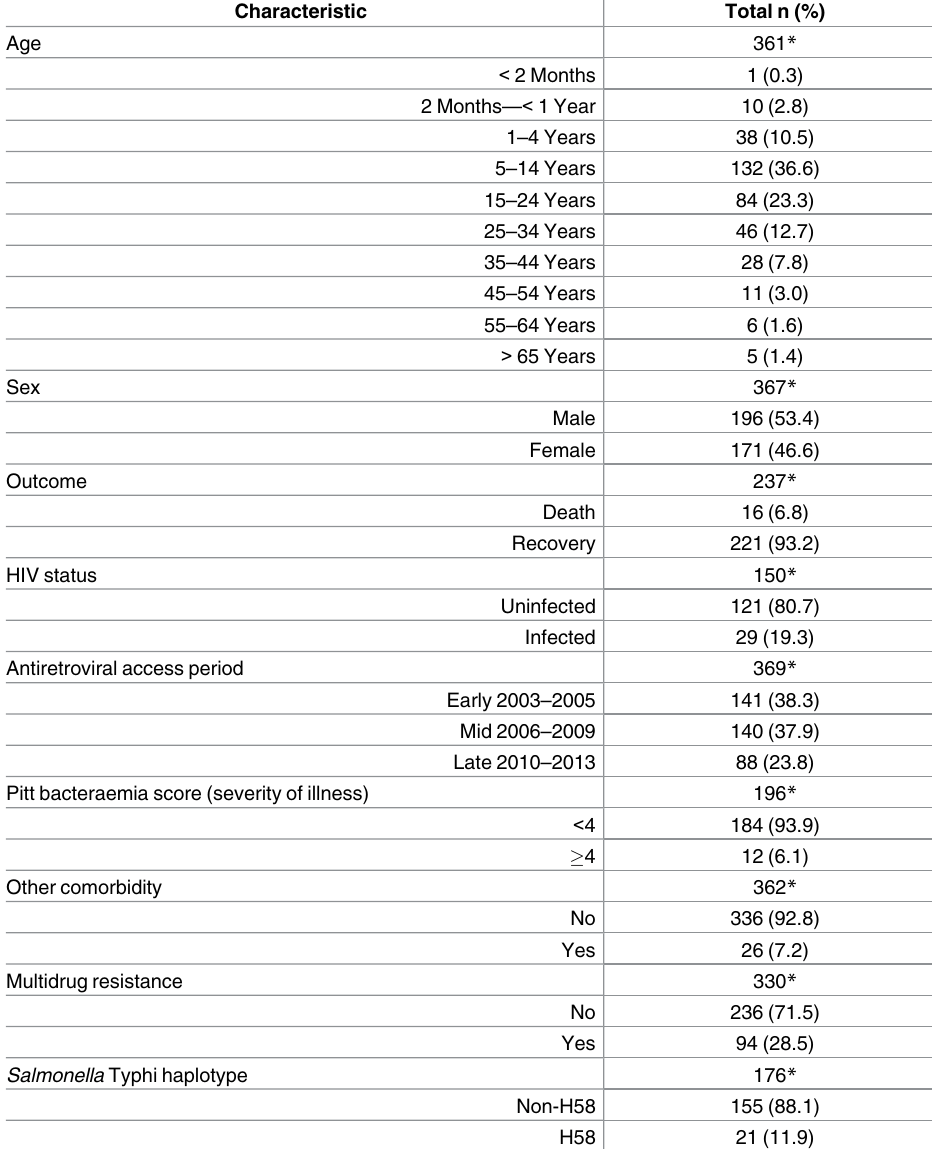
Final hospital outcome data were known for 55 of 158 (34.8%) typhoid fever patients infected with multidrug resistant Salmonella Typhi; 5 (9.1%) of whom died. Outcome was known for 19 (90.5%) of the 21 typhoid fever patients infected with H58, of whom one (5.3%) died. On unadjusted analysis, age (cid:21) 15 years (Odds Ratio [OR] 4.1; 95% ConfidenceInterval [CI] 1.1–14.9), HIV infection (OR 11.3; 95% CI 3.0–42.4), and PBS (cid:21) 4 (OR 10.8; CI 2.9–39.5) were associated with death among typhoid fever patients (Table 3). On adjusted analysis, HIV infec- tion (Adjusted OR [AOR] 10.8; 95% CI 2.3–50.3) and PBS (cid:21) 4 (AOR 9.8; 95% CI 1.6–60.0)